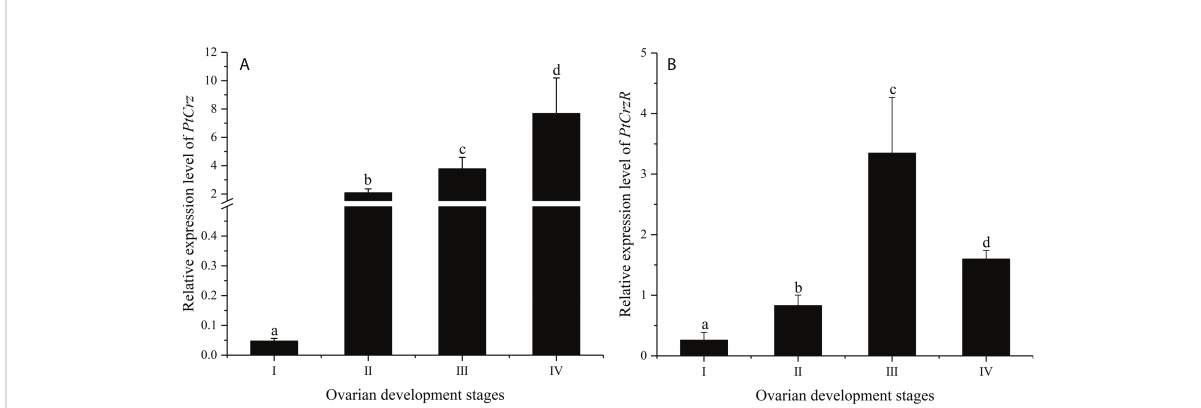
FIGURE 4 The expression of PtCrz (A) and PtCrzR (B) in the eyestalk ganglion and the Y-organ during the ovarian development were quanti fi ed respectively by qPCR analysis (n=4). Different letters indicate statistically signi fi cant differences ( P < 0.05) within each stage. I: previtellogenic stage; II: endogenous vitellogenic stage; III: exogenous vitellogenic stage; IIV: near-mature stage.